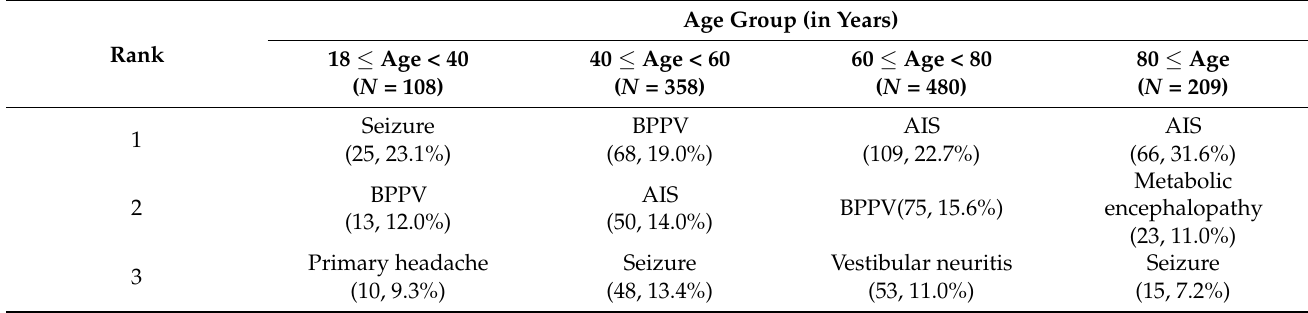
Figure 4. Emergency department diagnoses of the enrolled patients. Table 3. Emergency department diagnoses according to the age